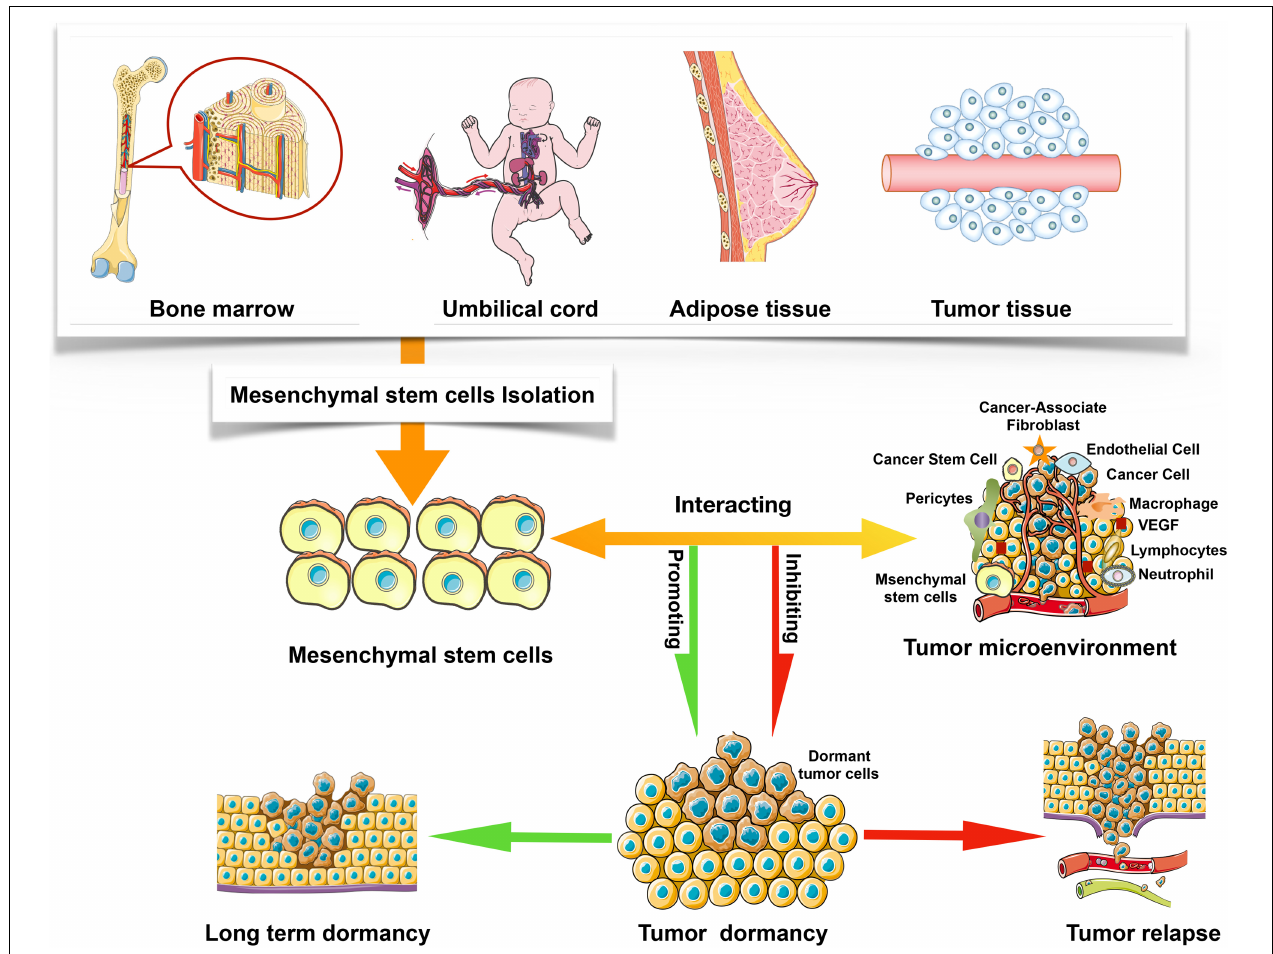
FIGURE 1 | The sources of MSCs and the interaction between MSCs and tumor microenvironment.